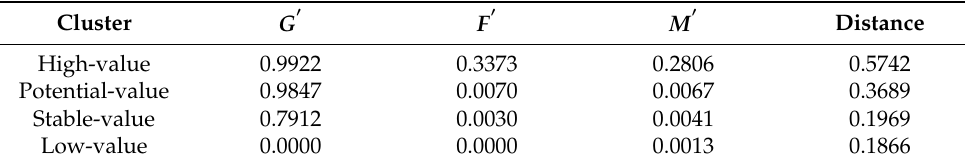
Table 4. Cluster centers of D S .